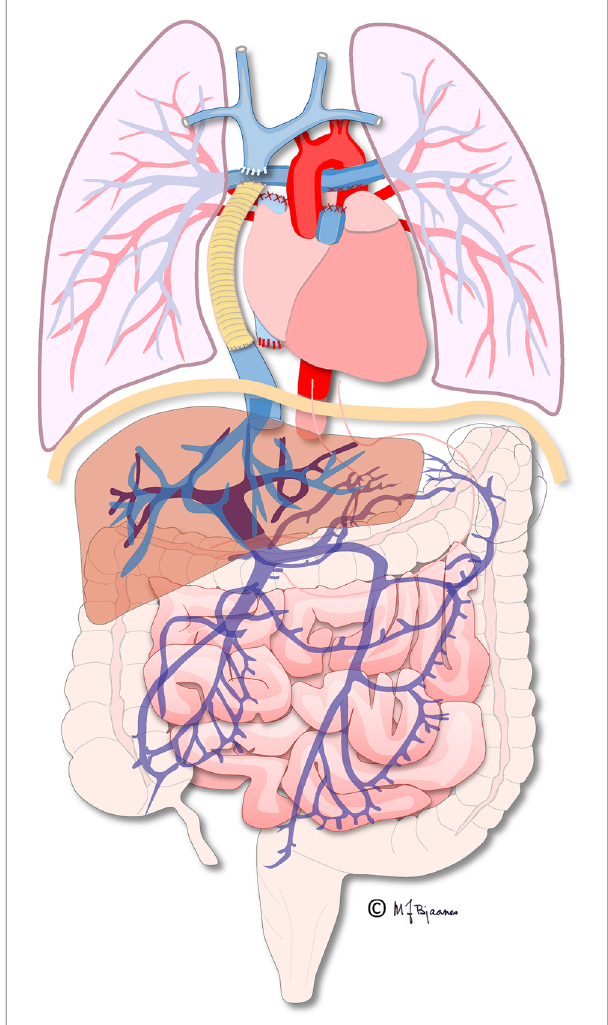
FIGURE 1 Illustration of the total cavopulmonary circulation with the extracardiac conduit connecting the inferior caval vein and the pulmonary arteries. Illustration created by Michael Bjaanes in collaboration with